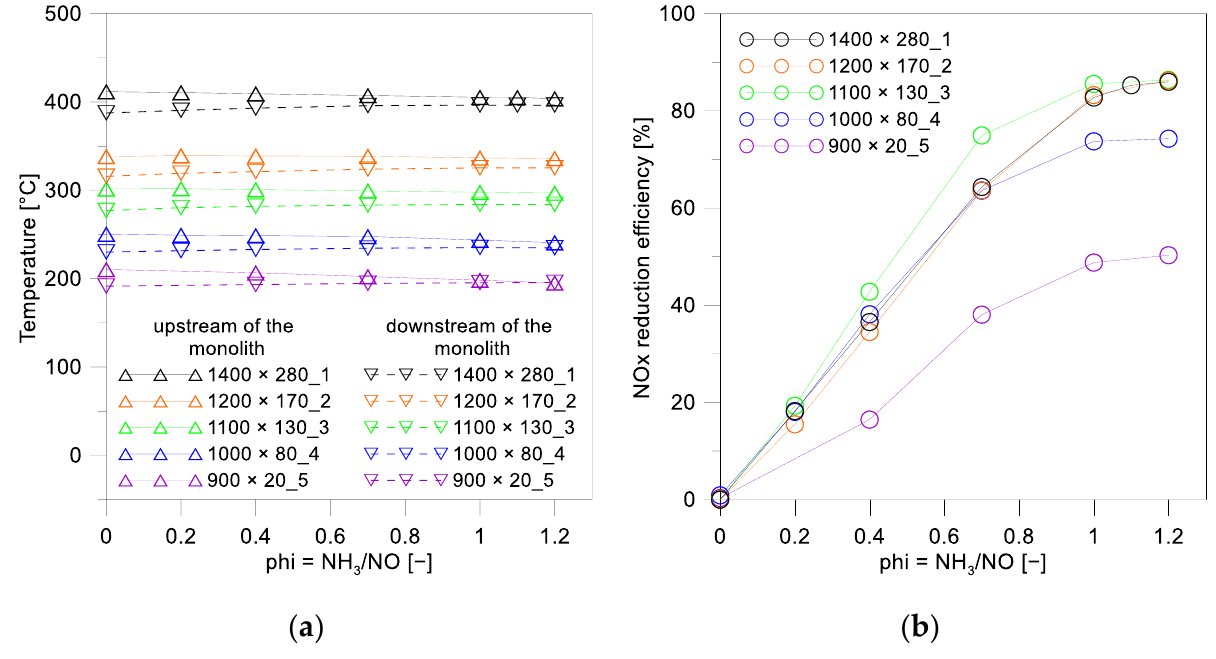
Figure 9. ( a ) Temperature upstream and downstream of the SCR system and ( b ) NO x reduction efficiency as a function of the dosing ratio (phi) with Adblue injection.